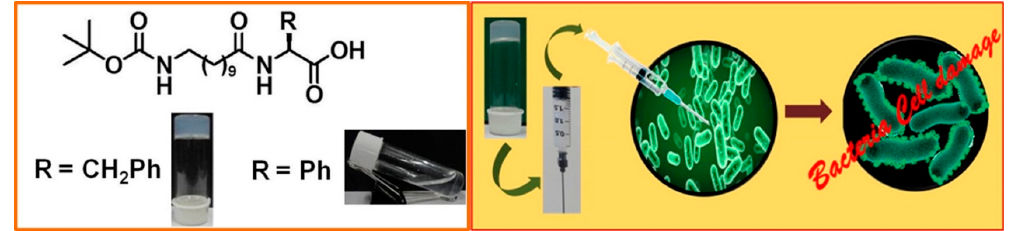
Figure 10. Chemical structures of the peptides and an illustration of the injectable nature of the hydrogel. Image adapted with permission from reference [53]. Copyright 2016 American Chemical Society.